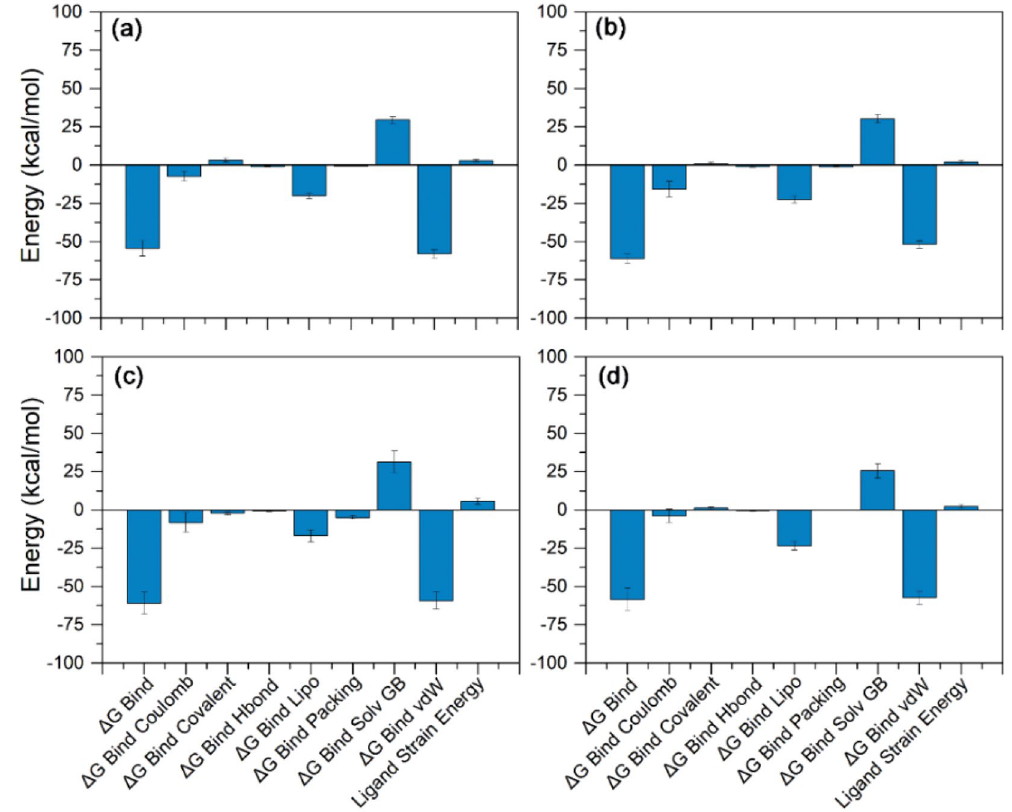
Figure 7. Binding free energy and individual dissociation energy components calculation performed for jRdRp protein docked with bioactive compounds, i.e. ( a ) Gedunin, ( b ) Nimbolide, ( c ) Ohchinin acetate, and ( d ) Kulactone, on the extracted poses from total 100 ns simulation